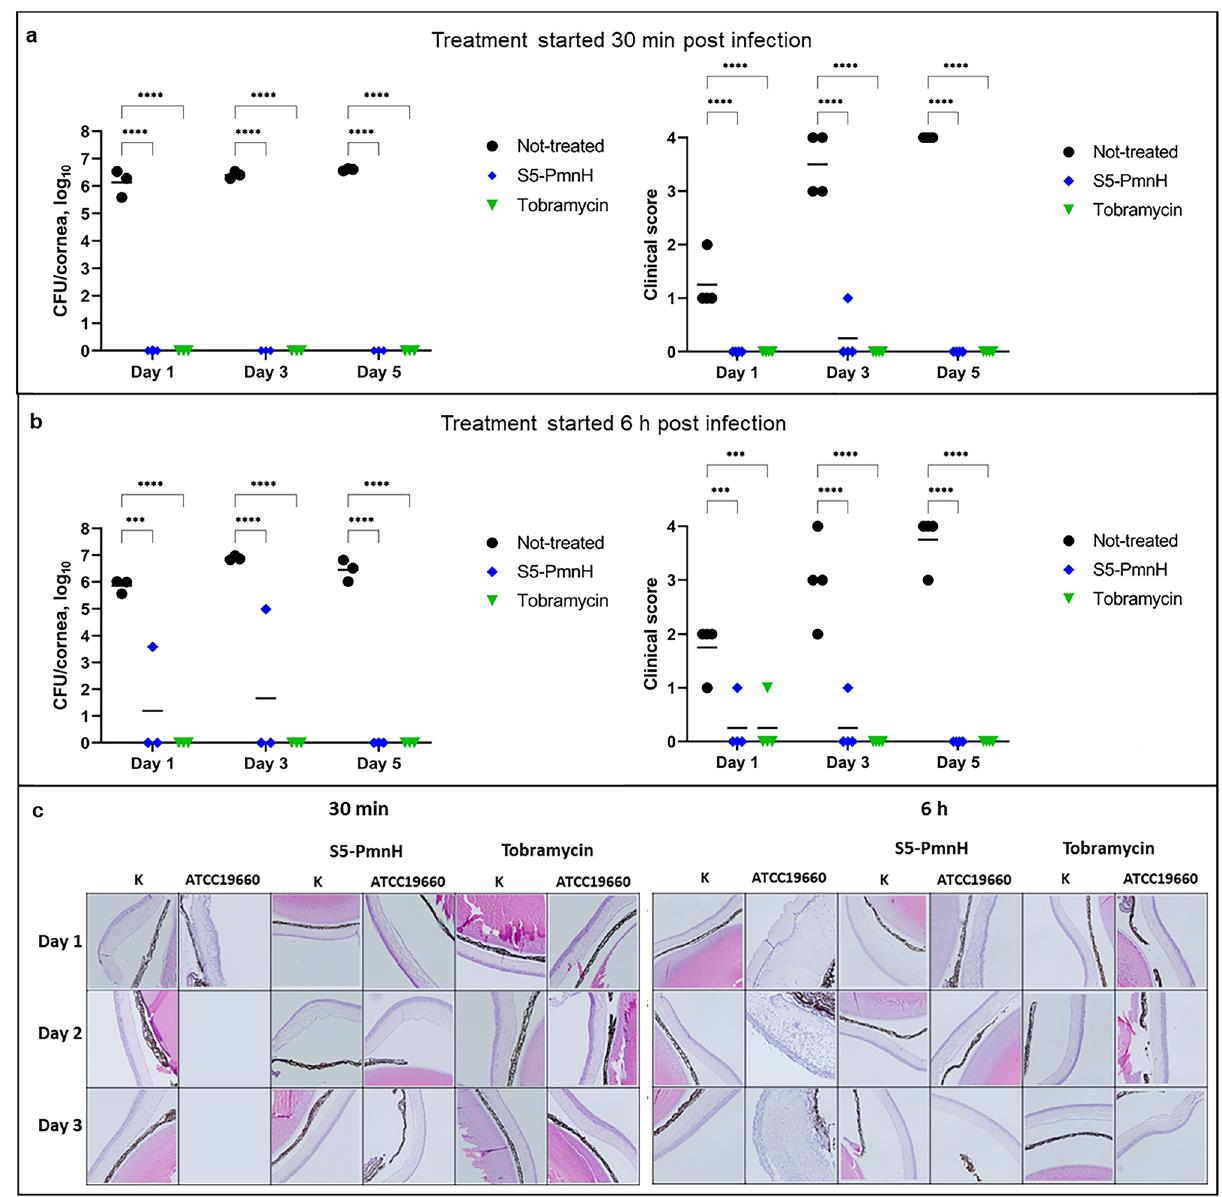
Figure 5. Mice cornea infection by cytotoxic strain ATCC 19660 and treatment by S5-PmnH or tobramycin. ( a ) CFU counts and clinical scores of mice eyes, when treatment started 30 min post-infection. ( b ) CFU counts and clinical scores of mice eyes, when treatment started 6 h post infection. ( c ) Hematoxylin–eosin staining of cornea sections. Left panel—treatment with pyocin started 30 min post-infection. Uninfected eyes—no observed microscopic aberations. Infected control eyes: day 1—strong corneal inflamation, days 3 and 5—the histology was not possible because of disrupted structure of the eye. Weak edema in the corneal stroma is observed in all infected eyes treated with S5-PmnH and with tobramycin. Right panel—treatment with pyocin started 6 h post infection . Uninfected eyes: no marked cornea abberations. Infected untreated eyes: day 1— thinning of corneal epithelium, thickening of stroma, acute inflammation, days 3 and 5—acute suppurated inflammation of cornea. S5-PmnH-treated infected eyes: day 1—acute inflammation of cornea, days 3 and 5— no marked aberrations, week edema of corneal stroma. Tobramycin-treated infected eyes: day 3 and 5—slight thickening of epithelium. Statistical significances of the quantitative data were analyzed using GraphPad Prism software by the 2-way repeated measures ANOVA and Dunnett’s correction for multiple comparisons. Mean is indicated by horizontal bar. ***P ≤ 0.001, ****P ≤ 0.0001 vs vehicle-treated